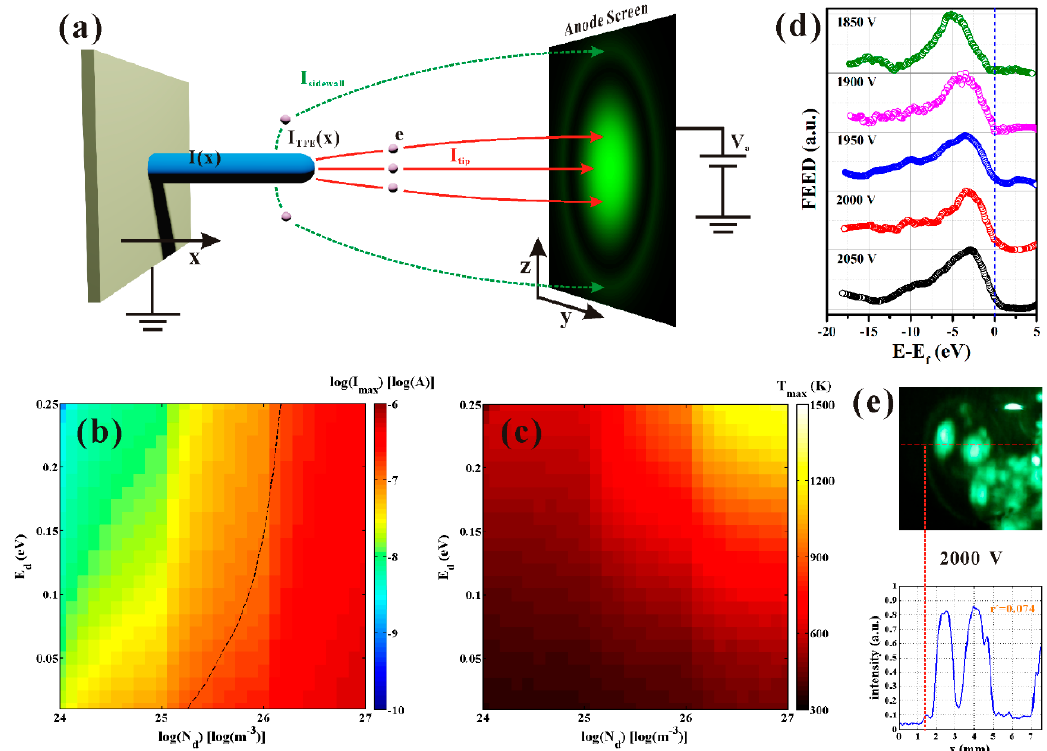
Figure 19. Field induced hot electron emission model of a ZnO nanowire under large current. ( a ) Schematic diagram of the emission current spatial distribution. ( b ) Calculated maximum emission current of individual ZnO nanowire with different electrical properties before thermal runaway. ( c ) Calculated maximum temperature of individual ZnO nanowire with different electrical properties before thermal runaway. ( d ) Experimental field emission energy distribution. ( e ) Experimental field emission ring pattern. Reproduced from [60], with the permission of John Wiley and Sons, 2020.